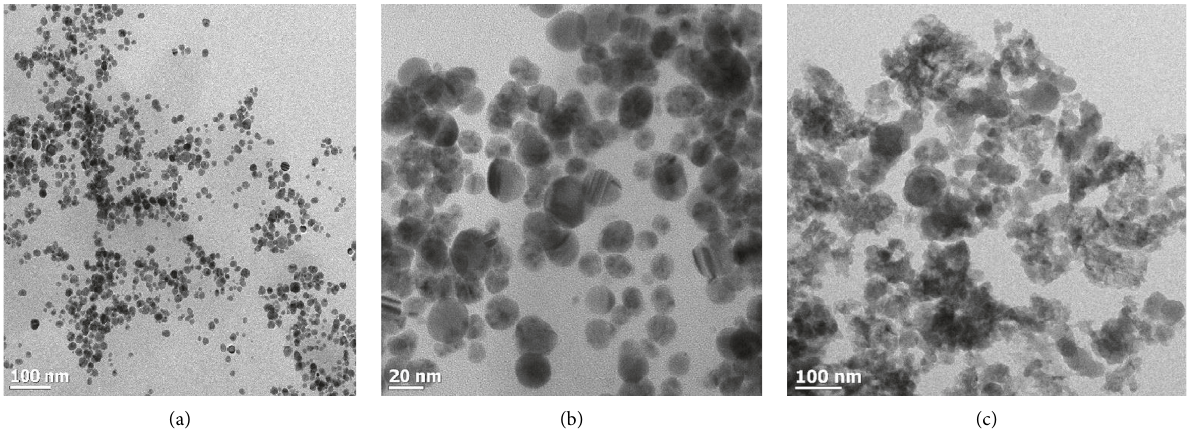
Figure 5: TEM micrograph. (a) AgNps; (b) scale bar Ag-MgO nanocomposite image at 20nm; (c) Ag-MgO at 100nm.